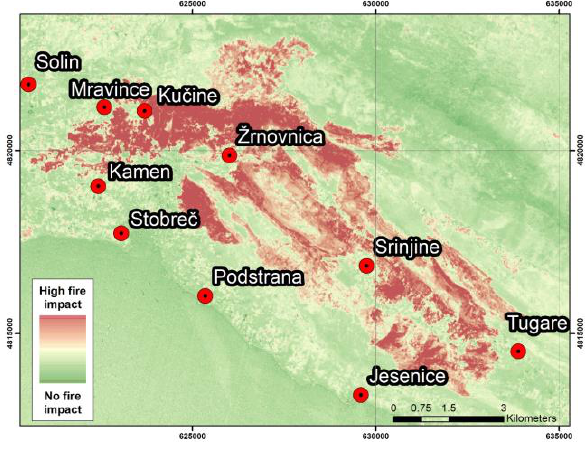
Figure 4. Burned area from satellite